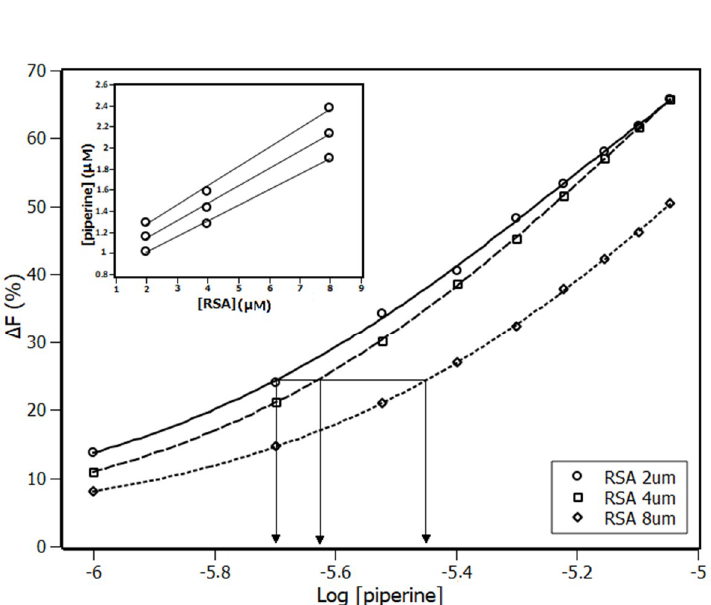
Figure 5. Plot of fluorescence titration of piperine with RSA at three different protein concentrations (2 µM, 4 µM, and 8 µM) at 288 K. Insert plot contains three sets of concentration pairs ([piperine]:[RSA]).